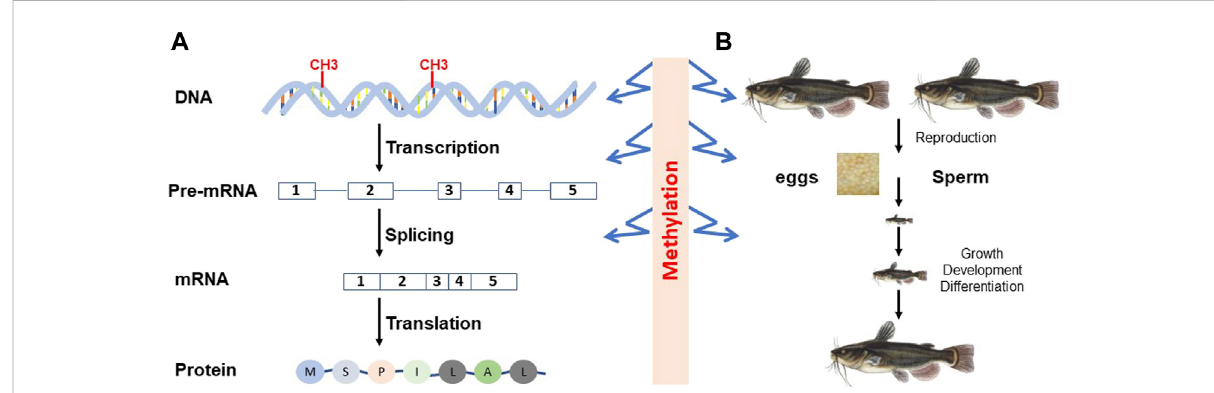
FIGURE 1 Epigenetic regulation of gene expression in the context of central dogma (A) and organismal development (B) . At the molecular level, DNA methylation can affect transcription and mRNA splicing, leading to different types or different amounts of transcripts. At the organismal level, DNA methylation is involved in gamete production, embryonic and later development, and